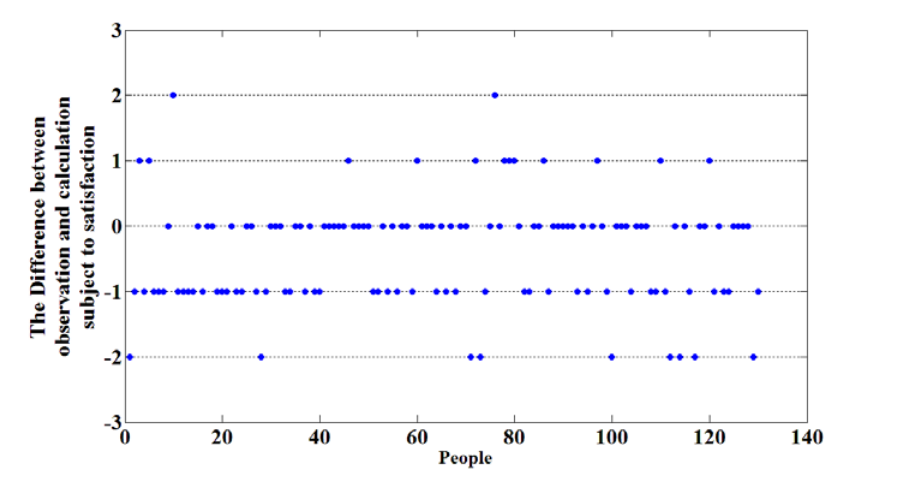
Fig. 1. The difference between observation and calculated job